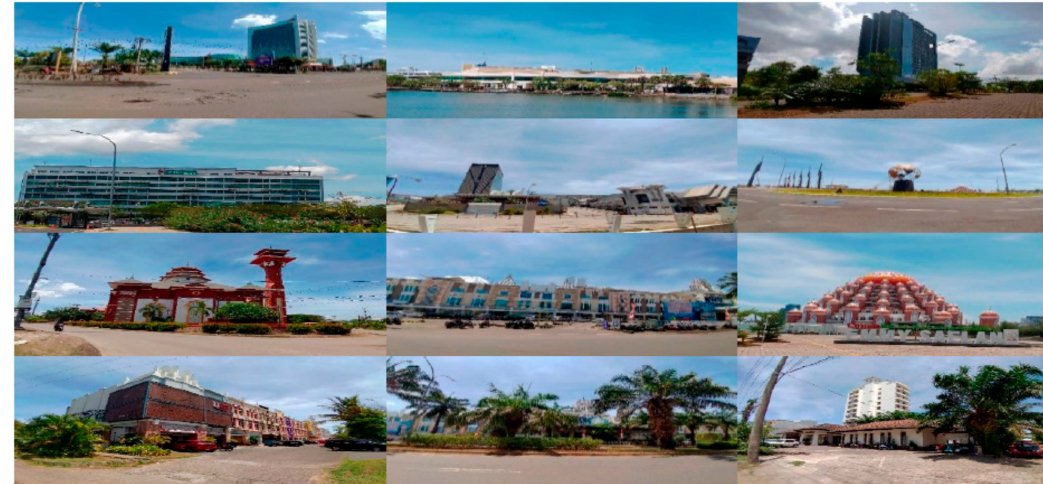
Figure 7. Expression of the spatial area of the new city area of Metro Tanjung Bunga in the period 2010–2012. Source: Primary